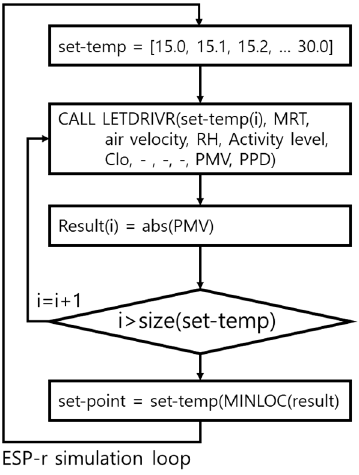
Figure 3. Analysis sequence in ESP-r for the calculation of the optimal